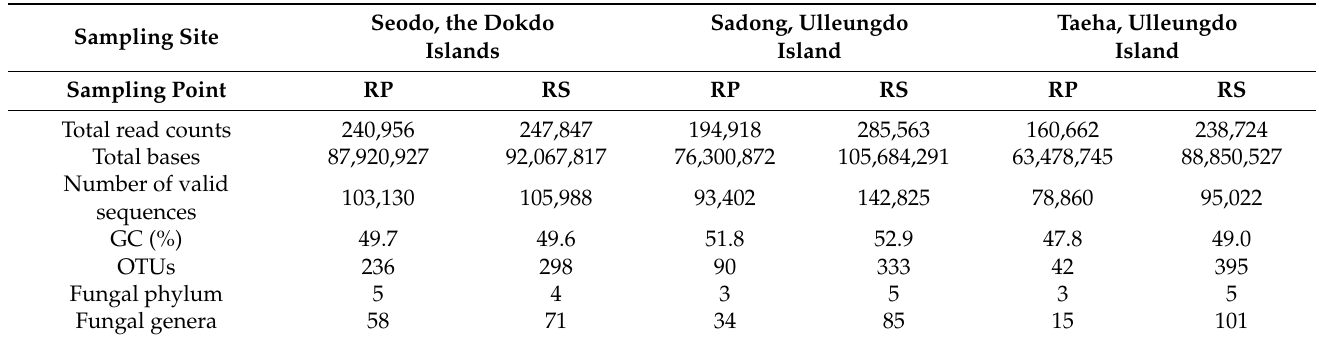
Table 2. Sampling site information comparison of Illumina MiSeq sequencing results.